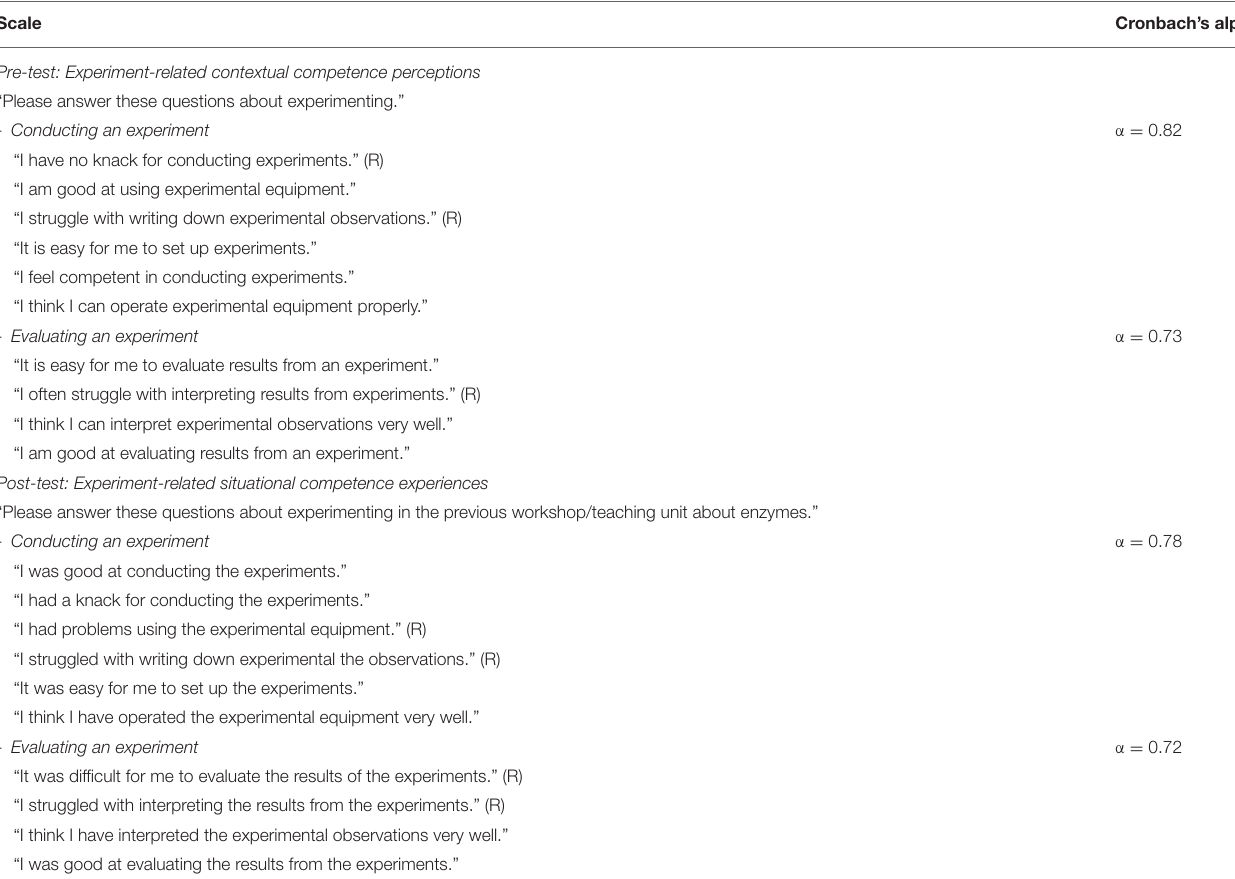
TABLE 1 | Test instruments with translated and adapted items and internal consistency (Cronbach’s alpha).